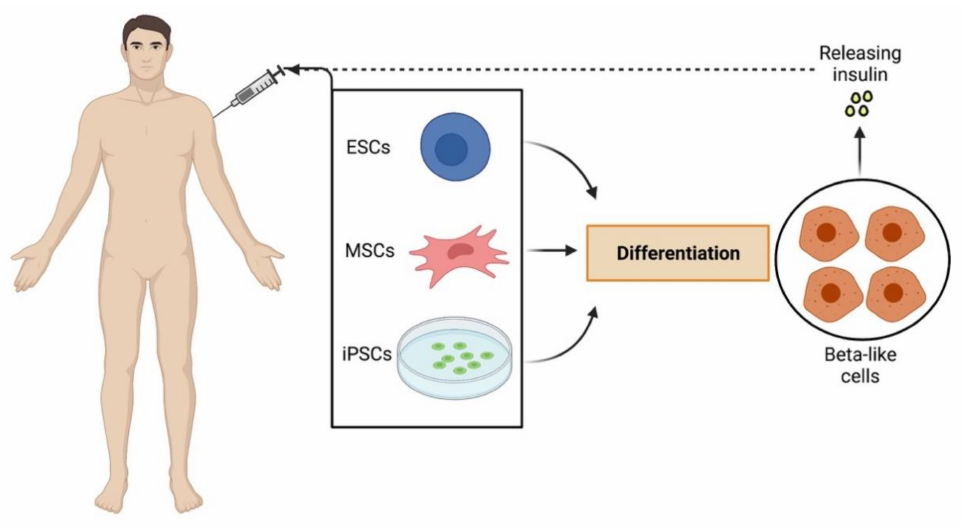
Figure 1. Representation of main stem cell approaches in type 1 and type 2 diabetes. Abbreviations: ESCs: embryonic stem cells; MSCs: mesenchymal stem cells; iPSCs: induced pluripotent stem